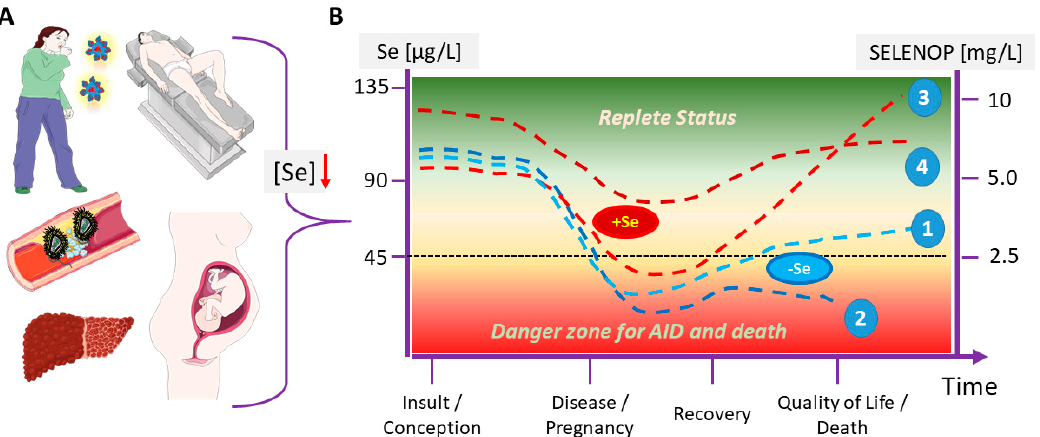
Figure 4. Hypothesis on Se decline into a critical zone as trigger for immune system failure, AID development, or even death. ( A ) Bacterial or viral infections, acute or chronic illness, AID, surgery, liver disease, or pregnancy are associated with a vicious cycle of inflammation, increasing cytokine levels and decreasing Se status. During and following to these conditions, AID may develop. ( B ) A disease-related drop in Se status below a certain threshold into a critical concentration range (“danger zone”) impairs regular immune system function and potentially disrupts self-tolerance, leading to AID. (1) Under regular conditions, disease-associated Se decline is transient, recovering with time. (2) Fatal disease course is associated with strong Se status decline and lack of its recovery. (3) Supplemental Se (+Se) reduces both the Se trough and time spent in severe deficiency, thereby likely improving odds of convalescence. (4) The risk for dropping into the danger zone of severe Se deficiency and immune system failure can be reduced by early Se supplementation, thereby starting on a sufficiently high status, ideally in combination with adequate monitoring in order to provide the amounts necessary and avoid side effects, i.e., to substitute what is needed without supplementing beyond requirement.